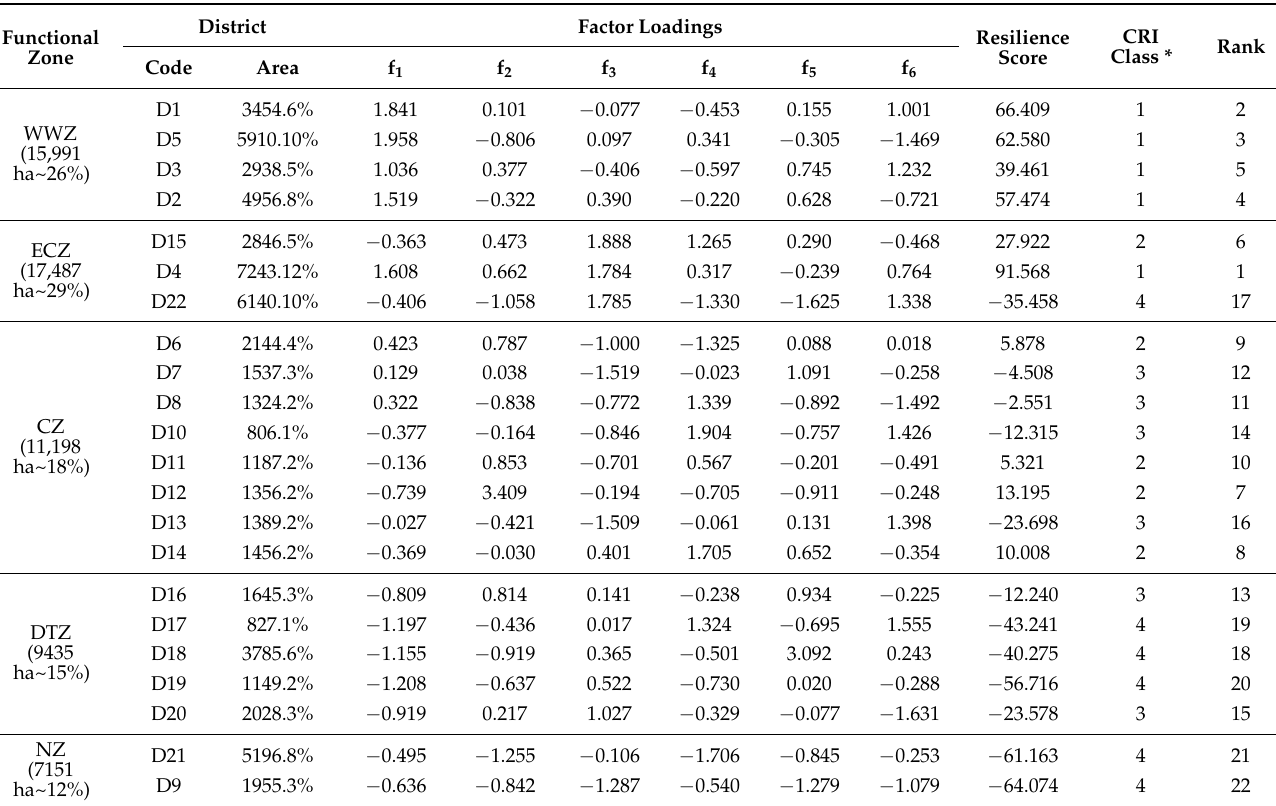
Table A2. Municipal districts loadings in